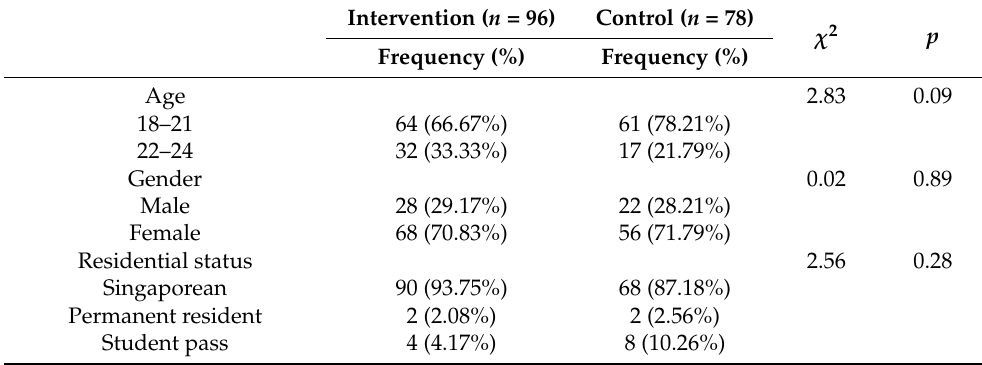
Figure 1. Consort flowchart. Table 1. Baseline demographic features and rating scores of the subjects within the 2